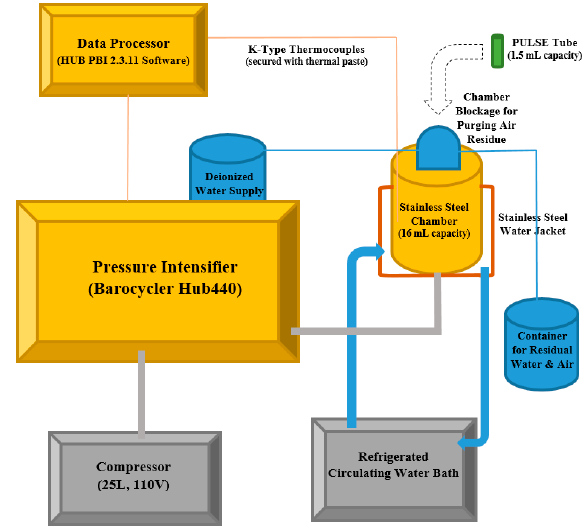
Figure 1. Schematic of high pressure processing unit utilized in current study at Public